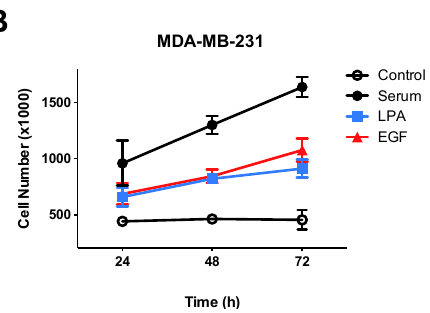
Figure 1. Effects of growth factors on proliferation of human breast cancer cells. Proliferation assays were conducted using serum-starved MCF-7 ( A ) or MDA-MB-231 ( B ) cells. Cells were incubated with or without 10% FBS (serum), 10 μ M LPA, or 10 nM EGF for the indicated times (growth factors were added at time “0”). Each data point represents the mean ± SEM ( n = 4) of values (number of live cells